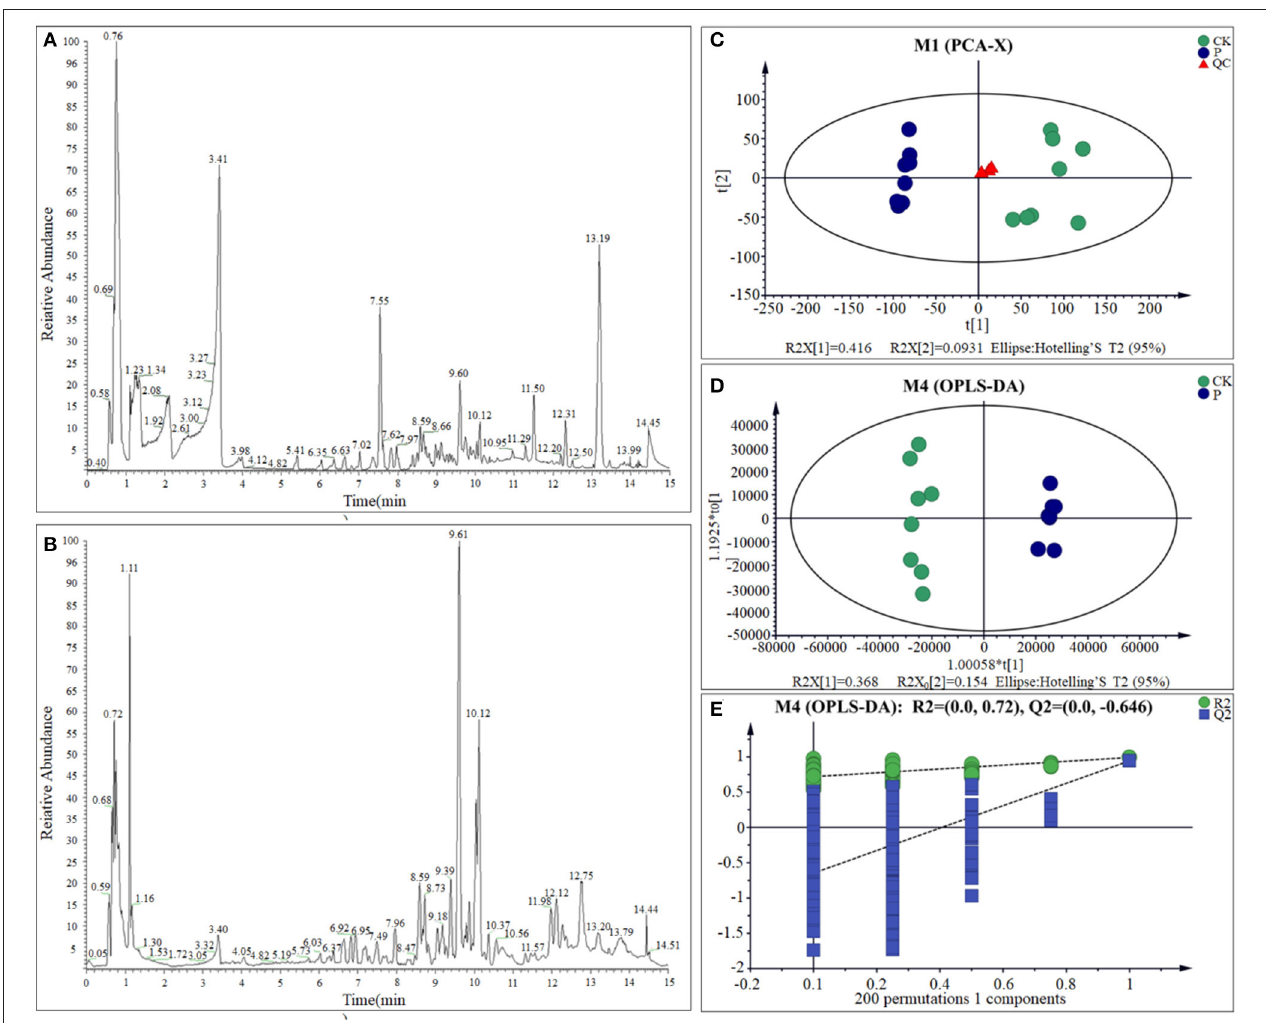
FIGURE 3 | BPC of gills sample from QC sample in ESI ( + ) (A) and ESI (–) (B) ; PCA scores plot (C) , OPLS-DA scores plots (D) , and response permutation testing (E) for CK and LS of the S.paramamosain .